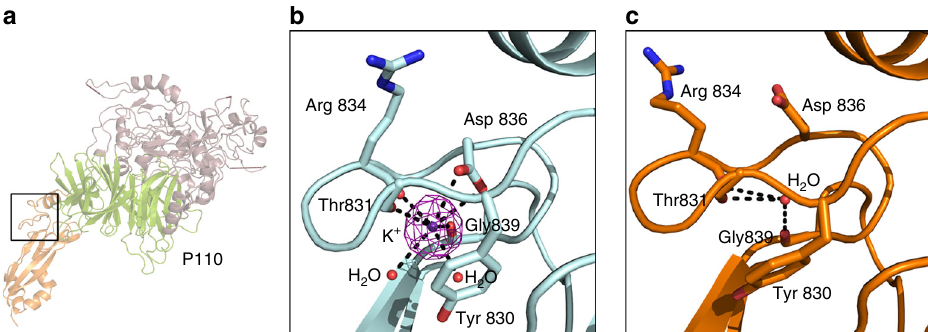
Fig. 5 Binding of Potassium to P110. a Overall views of the potassium binding site (indicated by a rectangle) in the C-terminal domain of erP110. Detail of the potassium binding site in the presence ( b ) and in the absence ( c ) of potassium. Electron density corresponding to the potassium is shown with a sigma weighted (Fo – Fc) omit map at four